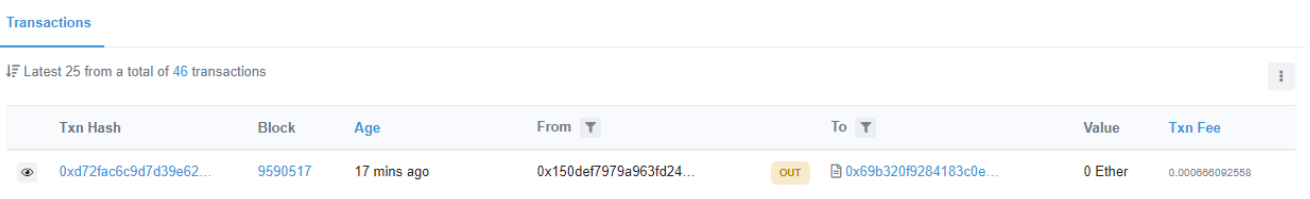
Figure 18. The record of transaction on